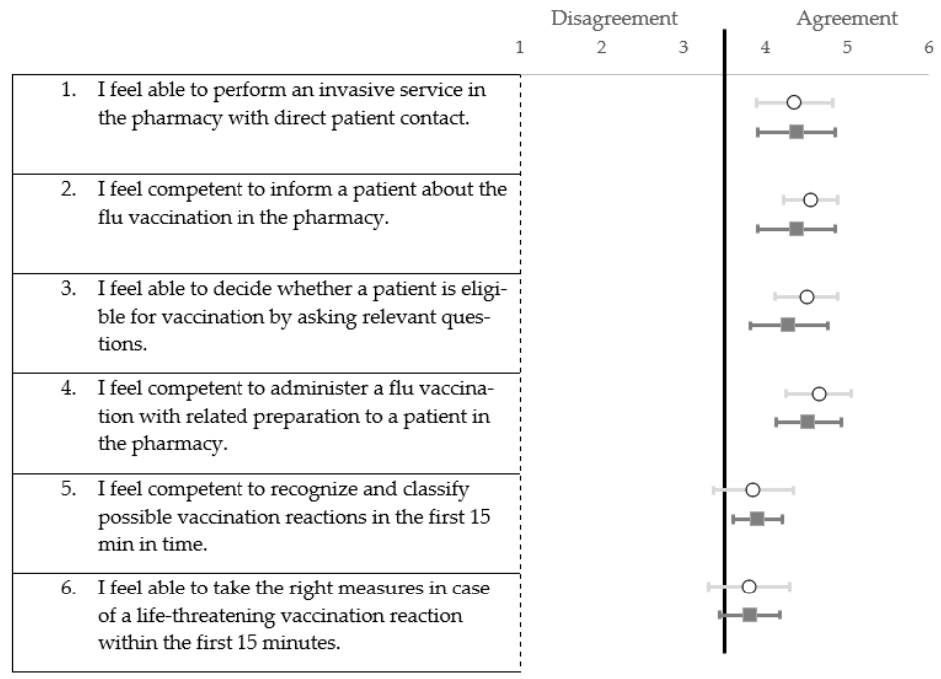
Figure 7. Forest plot of mean values with 95% confidence interval of self-assessment scores for question 1 to 6 in post-Training (6-point Likert scale). White dots ( ○ ) = intervention group (n = 20); grey square ( ▪ ) = control group (n = 21).